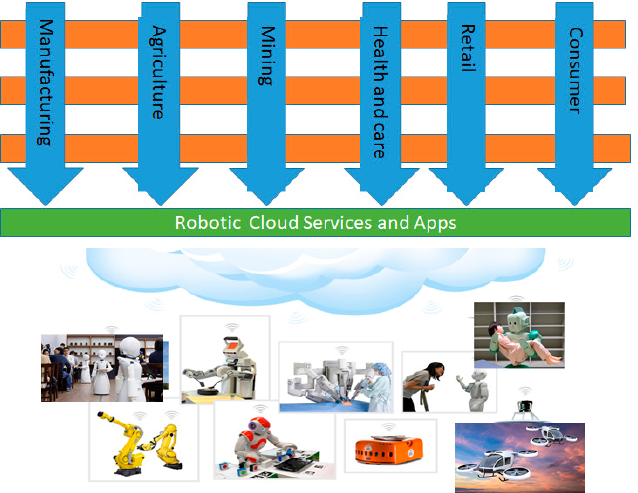
Figure 3. Transformation of robotics from specialized verticals to horizontal and virtualised robotic service platforms enabled by the IOR, and the emergence of a robotic apps ecosystem.